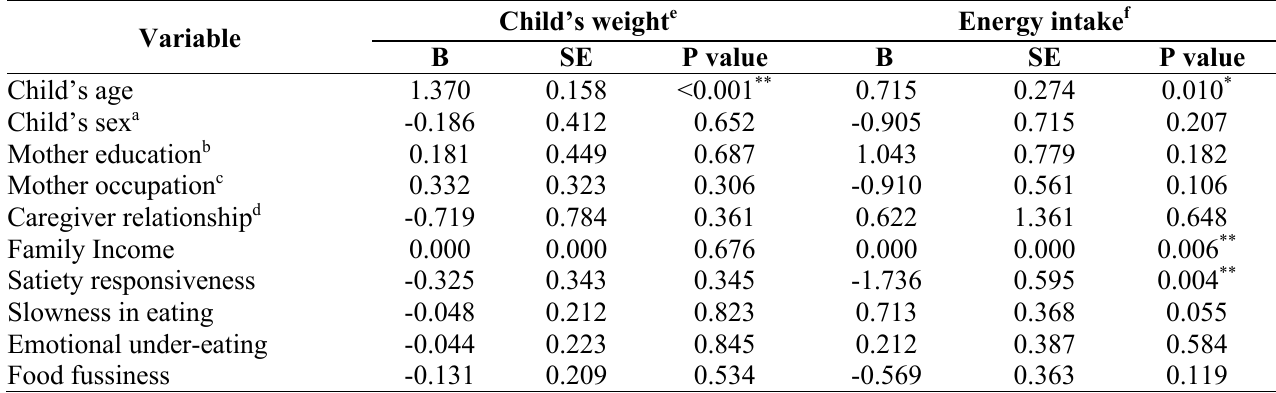
Table 4 . Multiple linear regression analysis for CEBQ subscale on child’s weight and energy